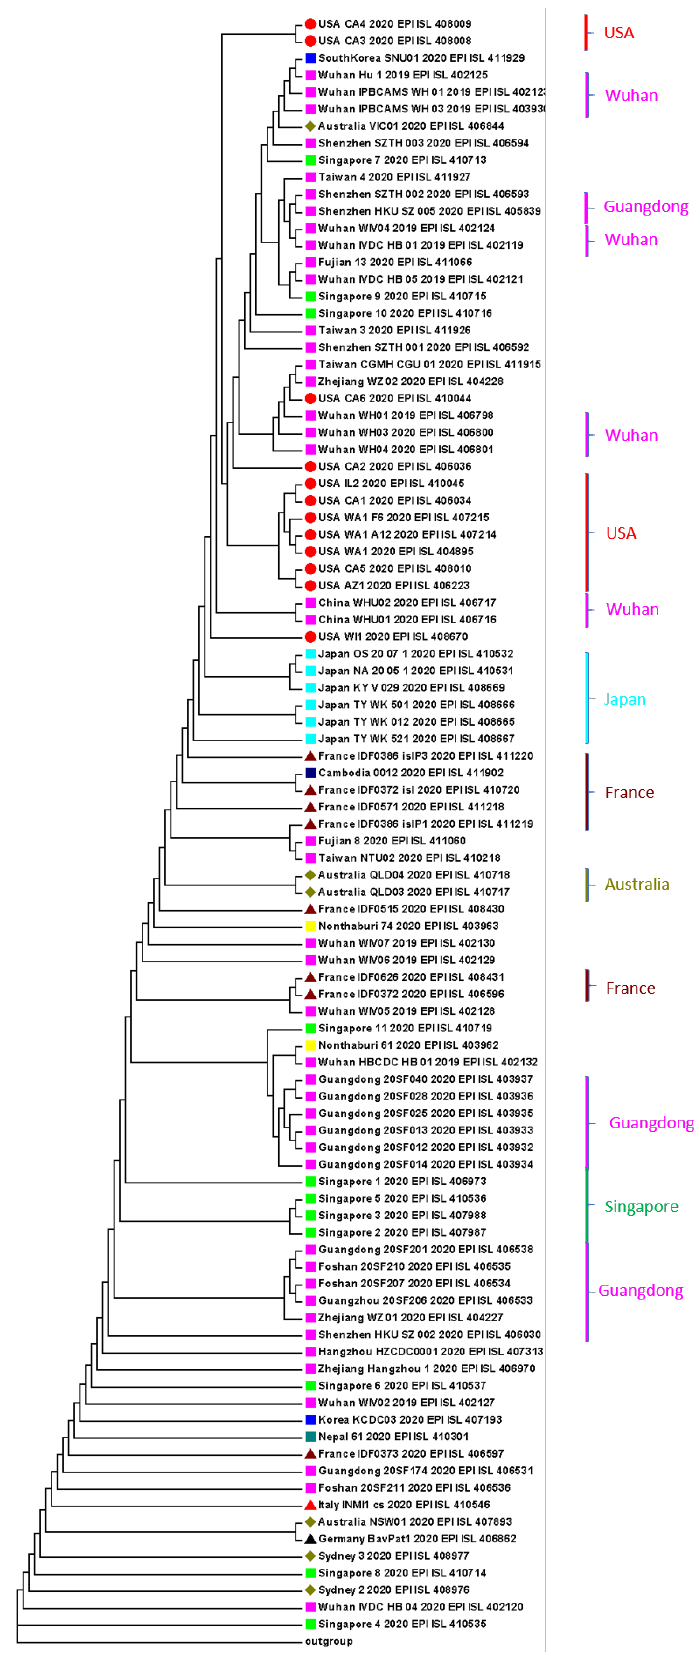
Figure 4. The phylogenetic tree of 95 SARS-CoV-2 strains where different colors represent the SARS-CoV-2 strains sampled from different